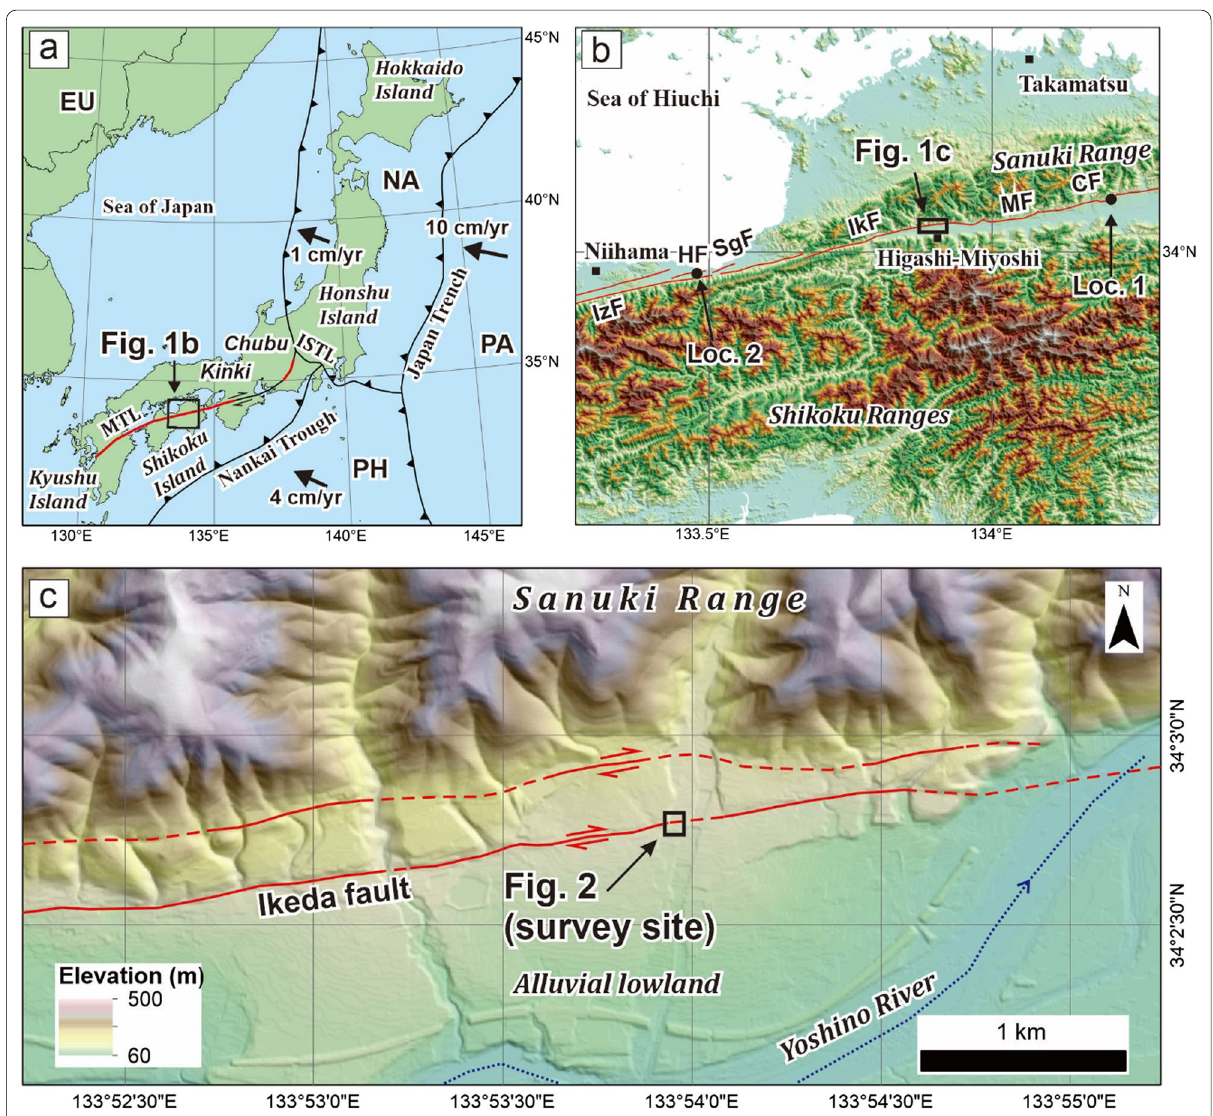
Fig. 1 a Tectonic map of the Japanese Islands. The plate motion vectors are calculated based on DeMets et al. (2010). Thick red lines indicate the active portion of the MTL. EU: Eurasian plate, NA: North American plate, PA: Pacific plate, PH, Philippine Sea plate, MTL: Median Tectonic Line, ISTL: Itoigawa-Shizuoka Tectonic Line. b Active fault traces of the MTL in central to eastern Shikoku (Tsutsumi and Okada 1996). Locs. 1 and 2 denote the surveyed locations of paleochannel offsets by Okada and Tsutsumi (1997) and Goto et al. (2003), respectively. IzF: Ishizuchi fault, HF: Hatano fault, SgF: Sangawa fault, IkF: Ikeda fault, MF: Mino fault, CF: Chichio fault. The topographic base map is made from the SRTM data (https:// www2. jpl. nasa. gov/ srtm/). c Geomorphology of the area around the survey site. The Ikeda fault trace is from the Active fault database of Japan (https:// gbank. gsj. jp/ activ efault). The topographic base map is made using the 5-m-mesh digital elevation model of the Geospatial Information Authority of